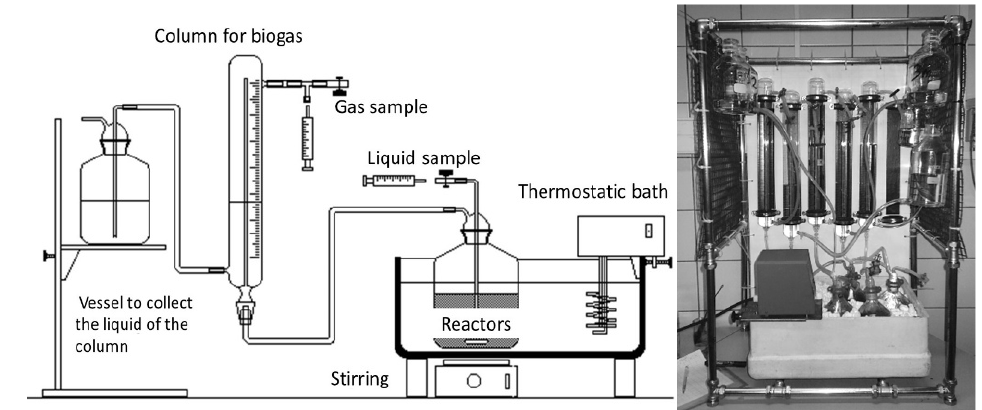
Figure 2. Scheme and picture of the used equipment in BMP tests.